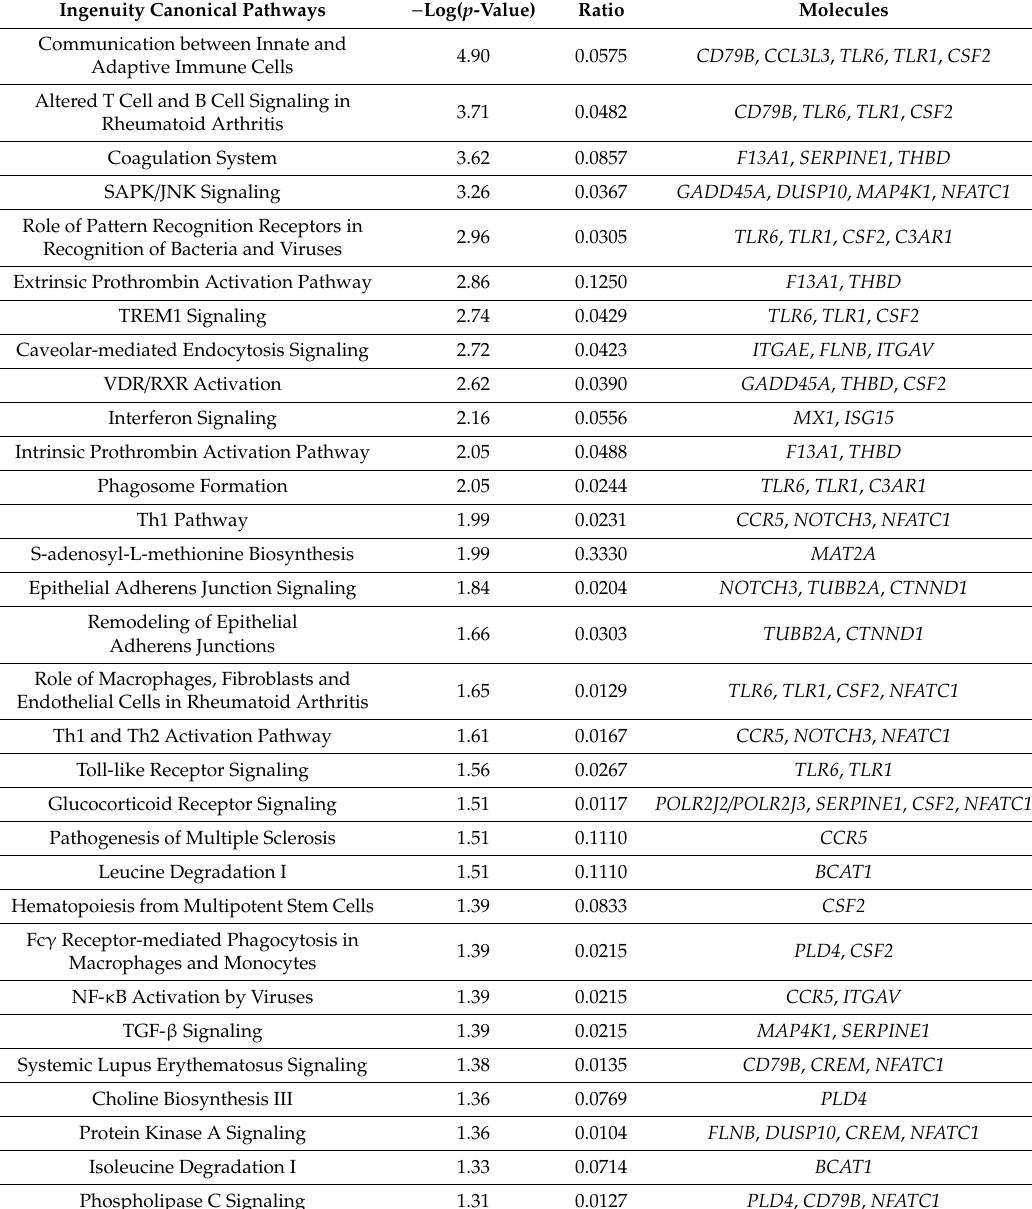
Table 3. Canonical ingenuity pathway analysis of the top 100 di ff erentially expressed genes in dendritic cells from patients with